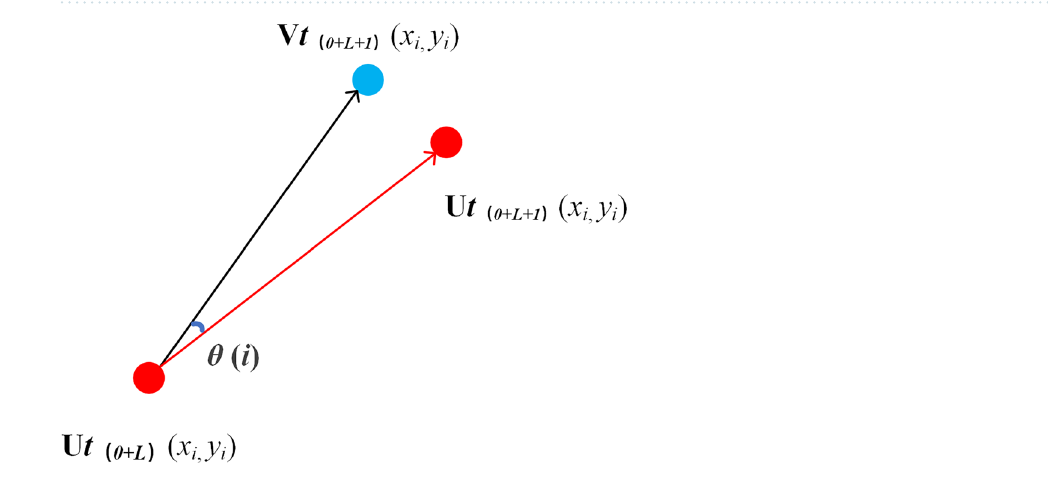
Figure 5. Motion vector filtering vanishing point in line